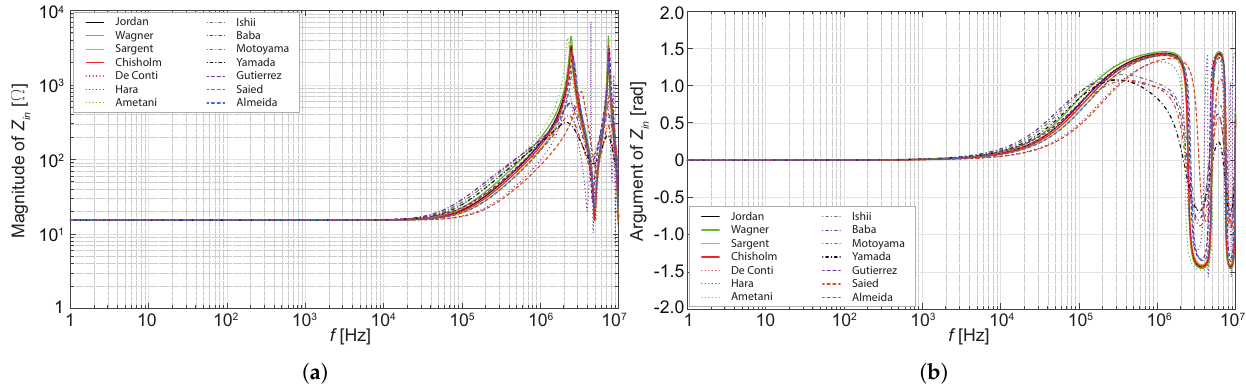
Figure 26. Input impedance Z in ( f ) seen at the top of tower (a) in Figure 16 over the soil with = 20, and R gr in Table 7. ( a ) Magnitude of Z ρ g = 150 Ω m, (cid:101) r g